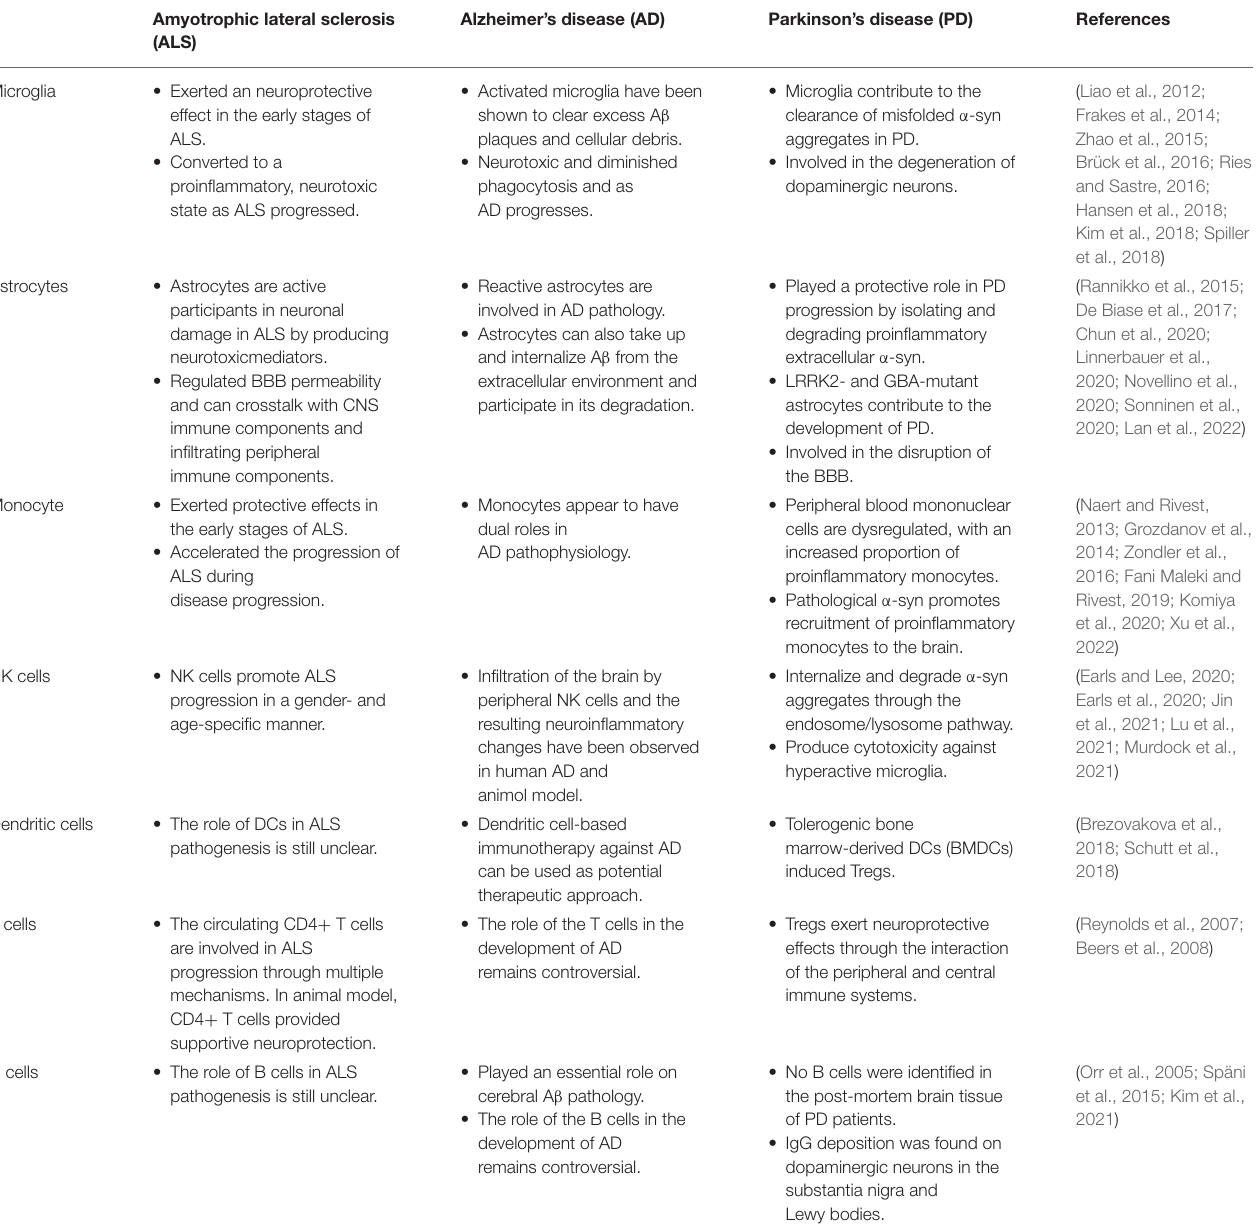
TABLE 1 | The role of central and peripheral immune cells on the pathogenesis of neurodegenerative